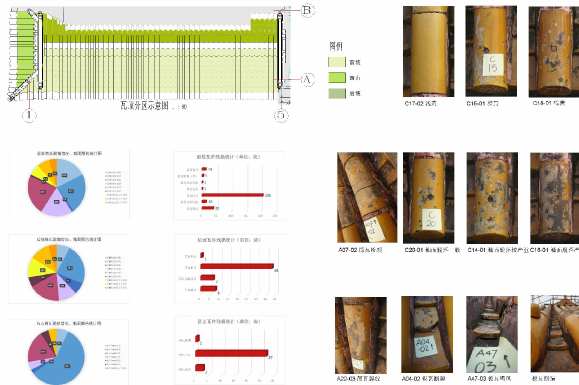
Figure 12 Examples of thematic drawings, theme: regular roofing tiles